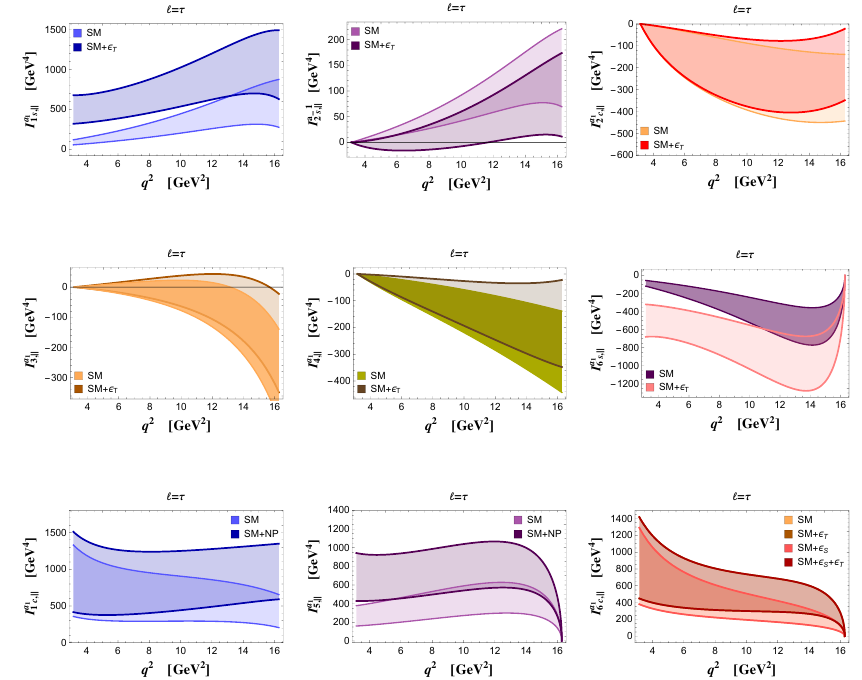
Figure 15. Angular coefficient functions for ¯ B → a 1 ( ρ (cid:107) π ) τ − ¯ ν τ (same notations as in Figure